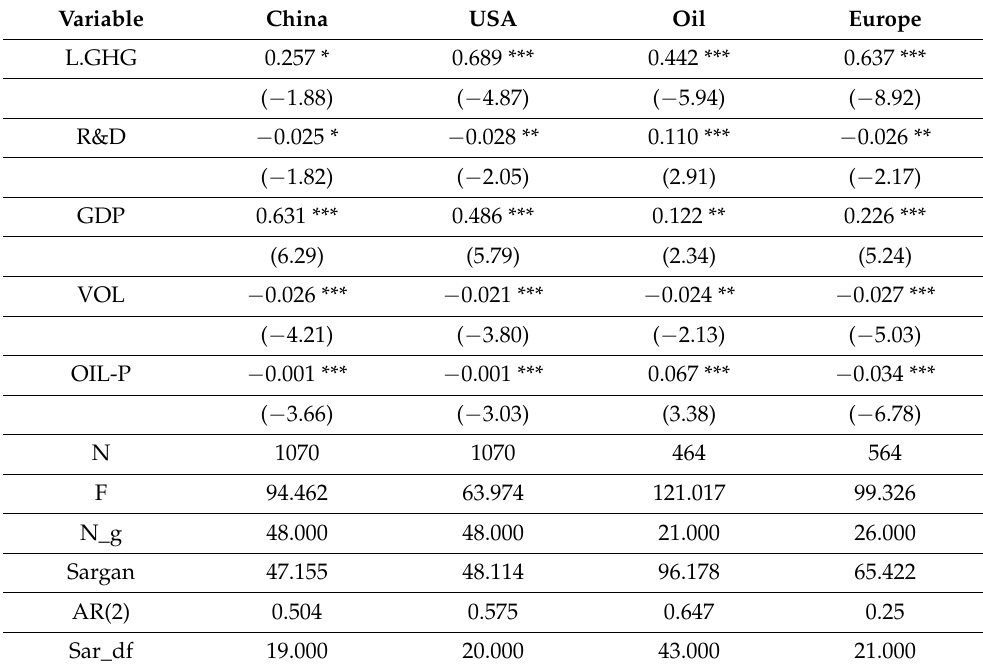
Table 4. Results from the generalized method of moments (GMM)-Differenced